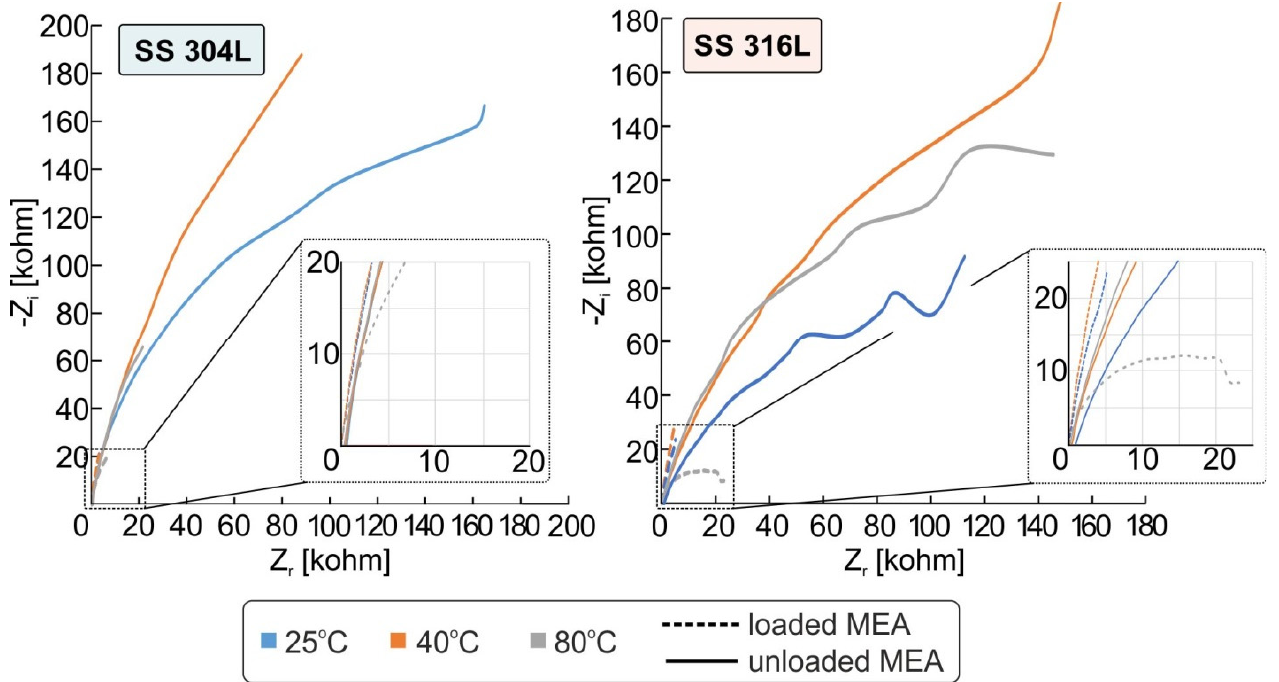
Figure 6. Nyquist plots for SS304 and SS316L at 25 °C, 40 °C and 80 °C when immersed in unloaded and loaded MEA solution.